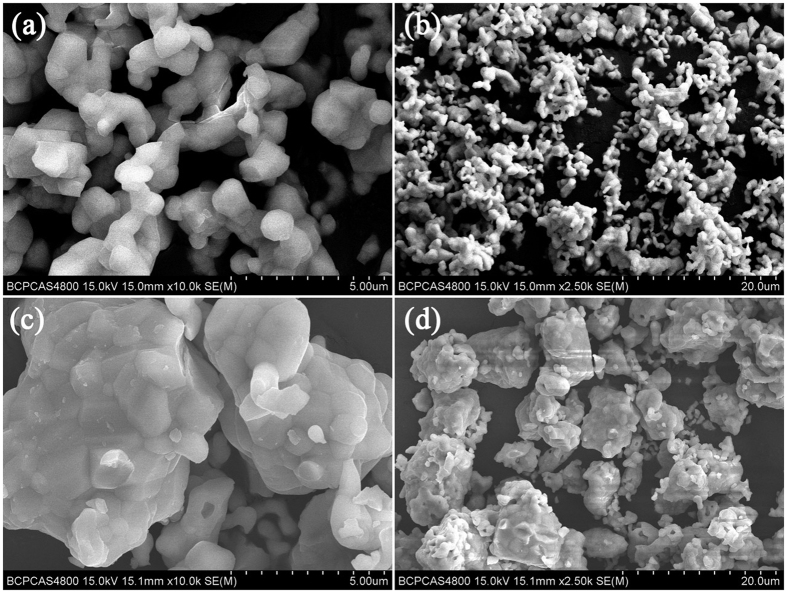
SEM images of the LaSiO2N:0.06Eu phosphors prepared at (a,b) 1500 °C and (c,d) 1550 °C.